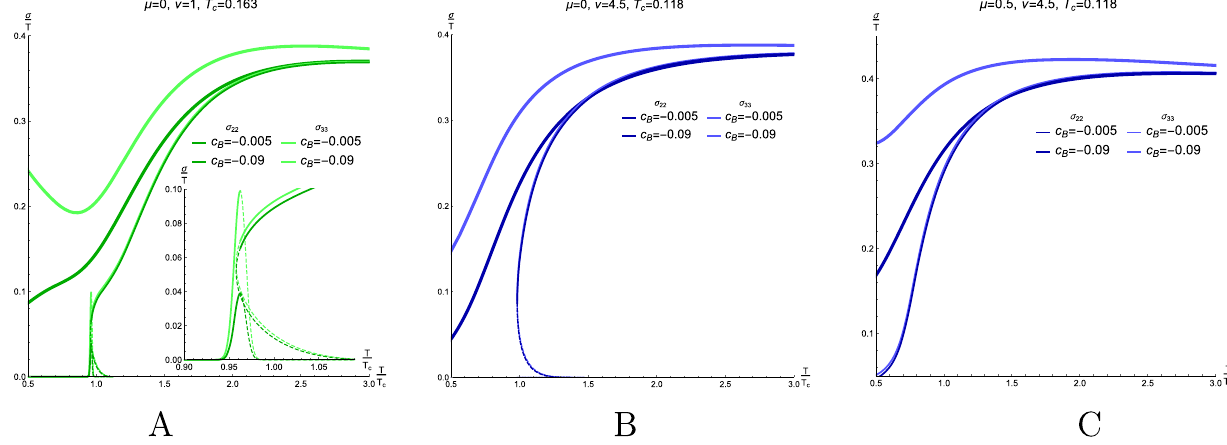
Fig. 11 The dependence of σ 22 / T and σ 33 / T on the normalized tem- perature T / T c for different values of magnetic field’s parameter c B and μ = 0 ( A , B ), μ = 0 . 05 ( C ). Here ν = 1 on A , and ν = 4 . 5 on B